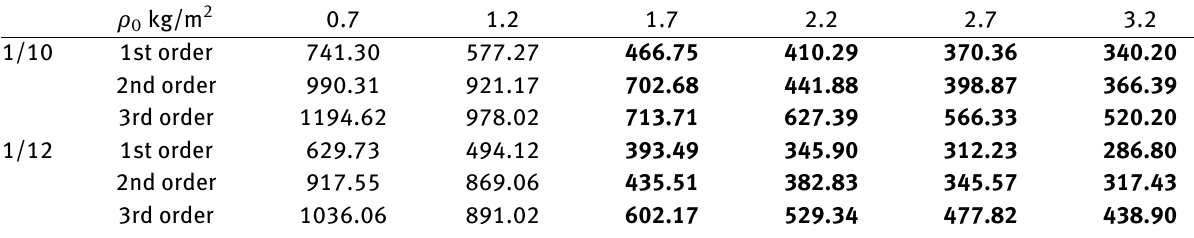
Table 8: The natural frequencies (rad/s) of analytical solutions under different material densities and rise span ratios